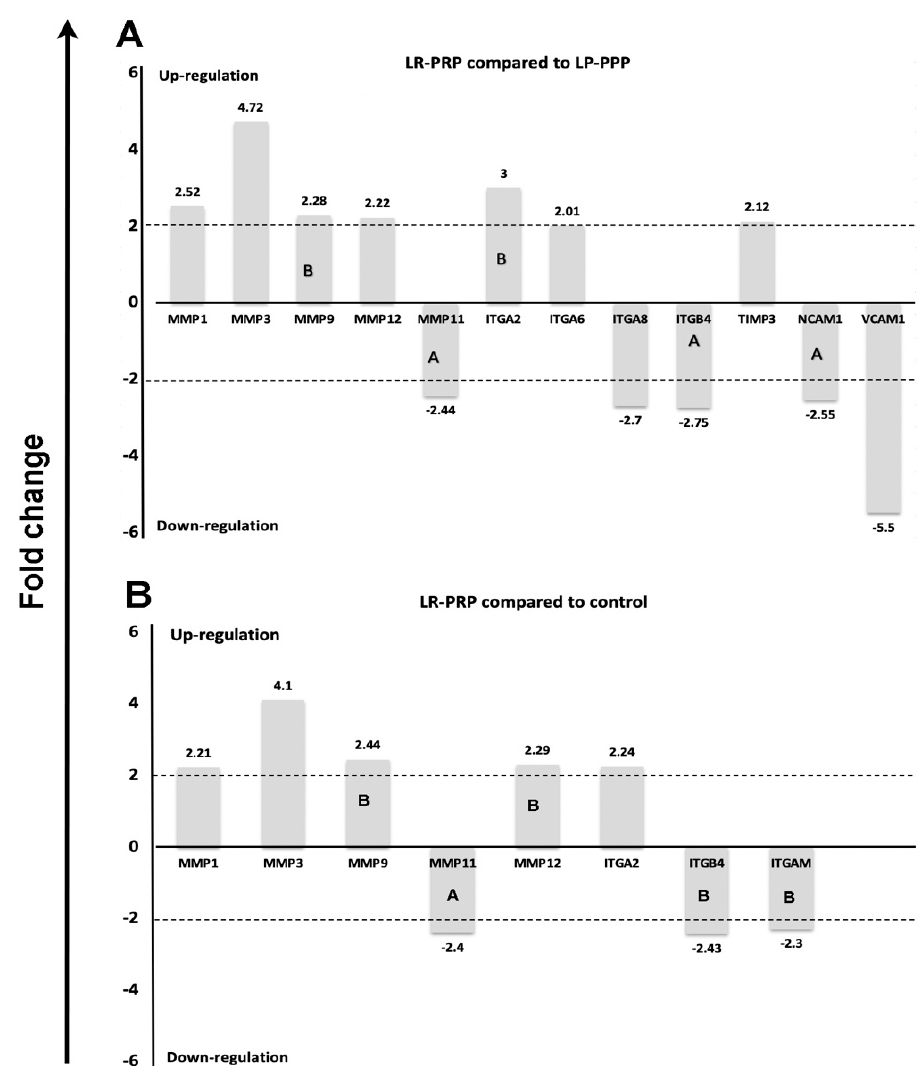
Figure 3. The human extracellular matrix and adhesion molecules RT 2 Profiler PCR gene array.